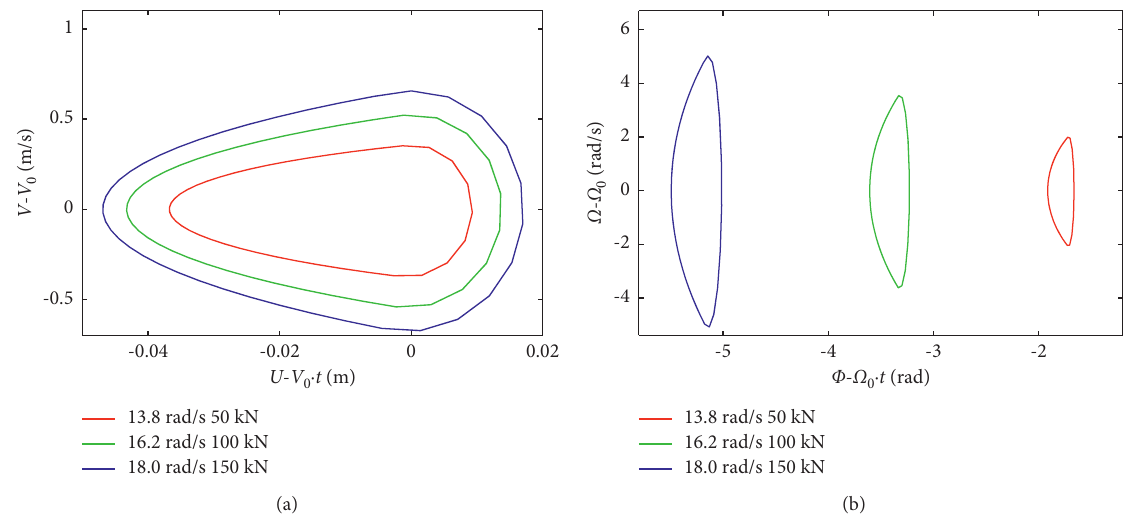
Figure 13: The phase diagram when the bit bounce phenomenon occurs, k diagram of torsional